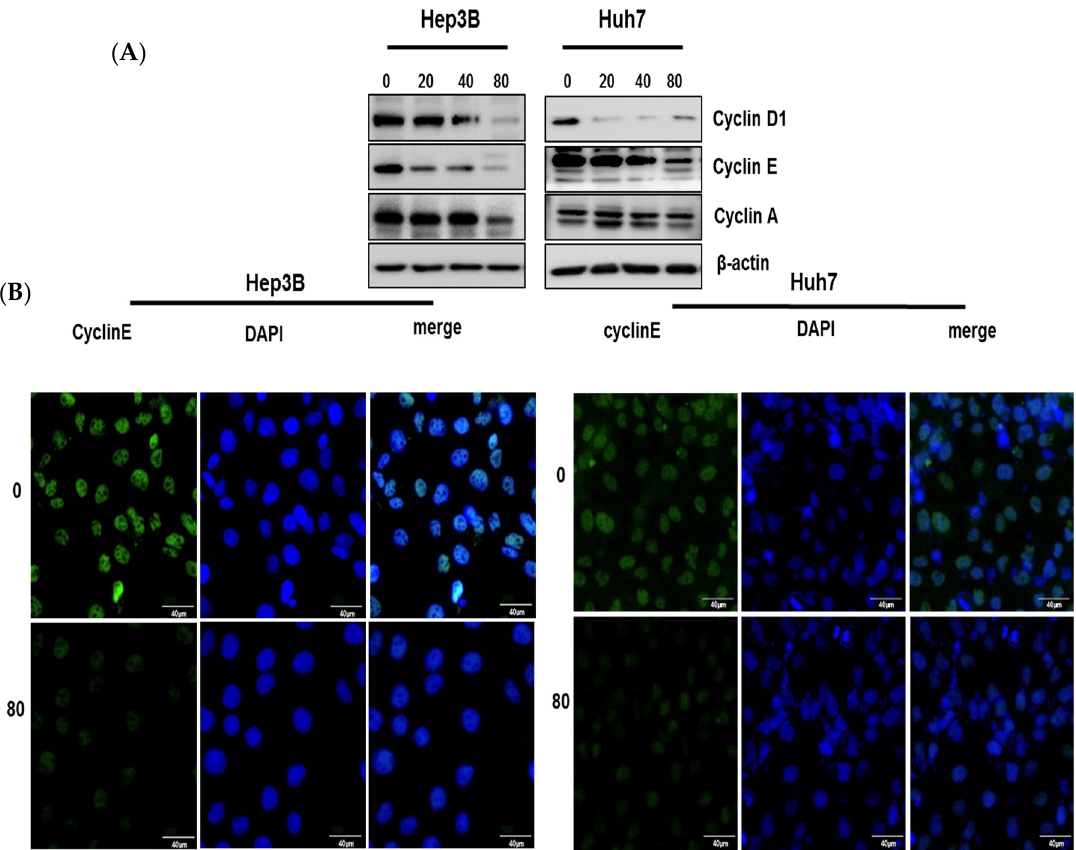
Figure 3. Pyrogallol regulated the expression of cell cycle-related proteins in Hepatocellular carcinoma. ( A ) Hep3B and Huh7 cells were treated with Pyrogallol (0, 20, 40, 80 μ M) for 24 h. Significantly decreased expression of cell cycle-related protein cyclin D1, Cyclin E, and Cyclin A by Western blotting. ( B ) Cells were treated with 80 μ M of Pyrogallol for 24 h and fixed, permeabilized, probed with Cyclin E antibody and secondary (FITC) antibody and were stained with DAPI and mounted in media and visualized under the FLUOVIEW FV10i confocal microscope (Olympuse, Japan). Scale bars= 40 μ m.